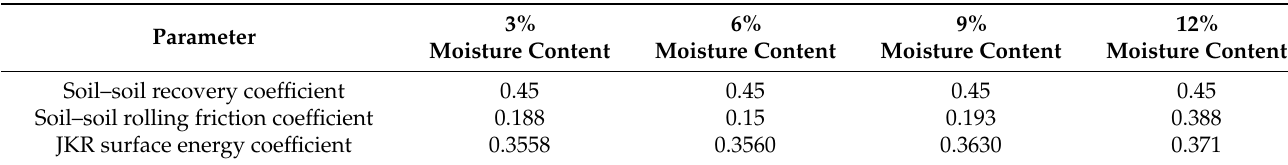
Table 11. Contact parameters for soil with different water content.